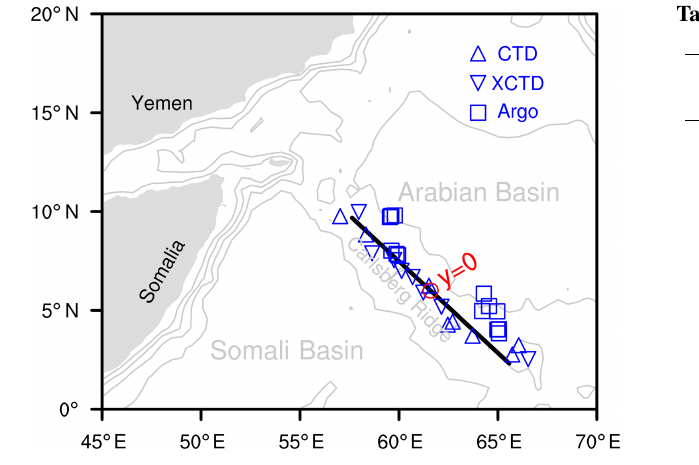
Figure 1. CTD/XCTD stations of the DY125-24 survey and the contemporary Argo profiles around the CR. The CR defines local coordinates in which the x coordinate is cross track and the y co- ordinate along track; the corresponding origin point is selected as 6.0 ◦ N, 61.6 ◦ E, and the isobaths of − 4000, − 3000, − 2000, and − 1000m are presented.